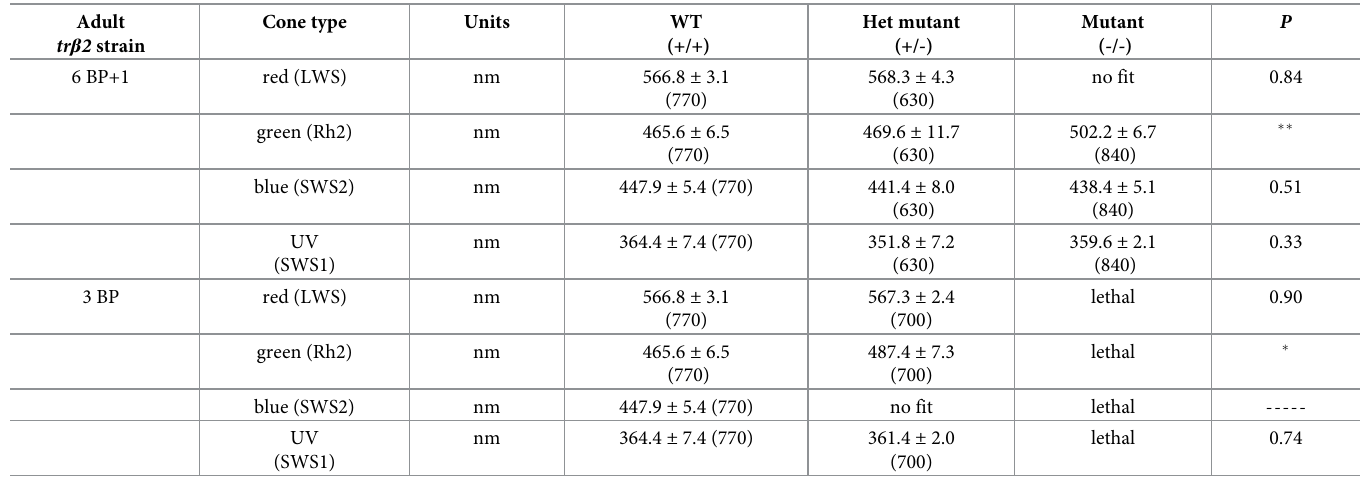
Table 4. Peak sensitivities of adult cones in tr β 2 genetic strains. Adult